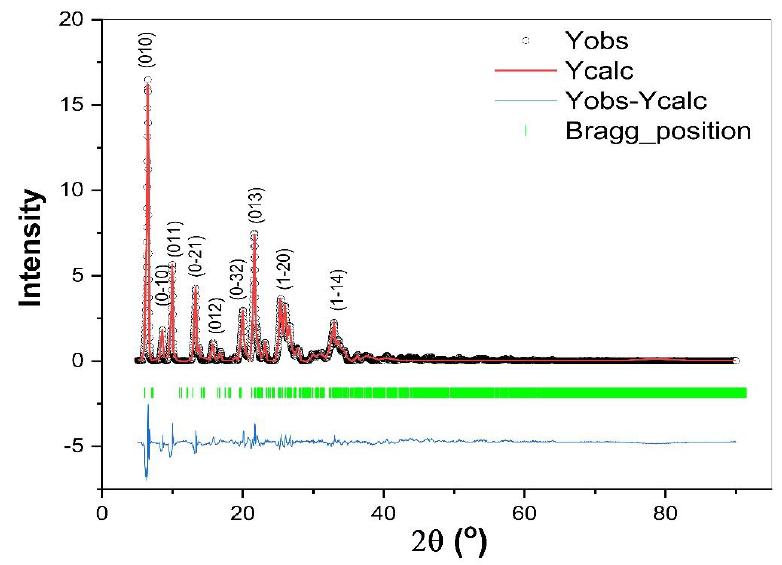
Figure 9. X-ray diffraction of compound 4 . The inset figure shows X-ray diffraction (Y obs ) and the refined diffraction pattern (Y calc ) using the Rietveld method.